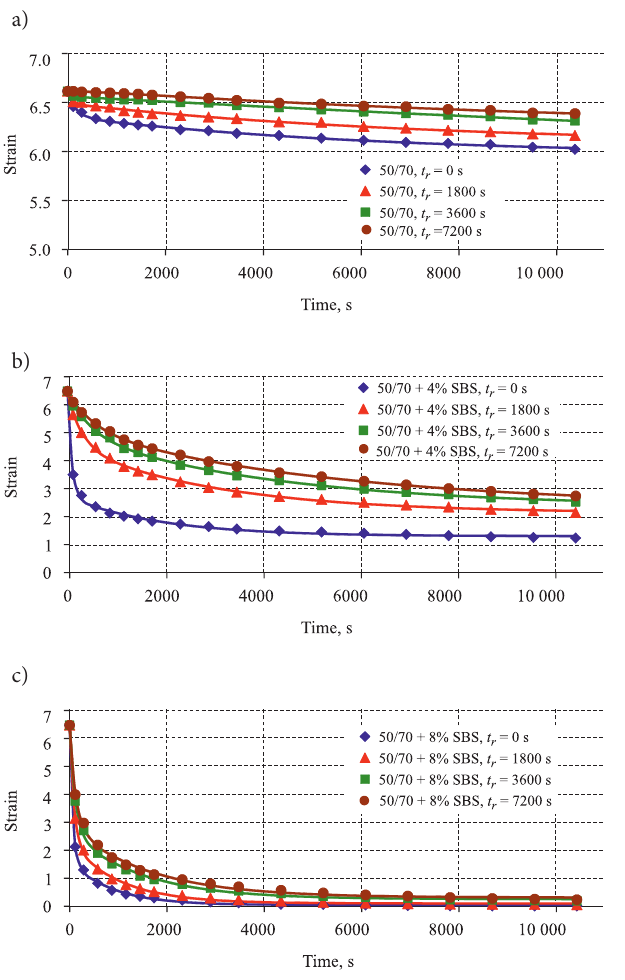
Fig. 6. Inverse creep curves of asphalt binders tested at 15°C: a – 50/70; b – 50/70 + 4% SBS; c – 50/70 + 8% SBS; the Dual